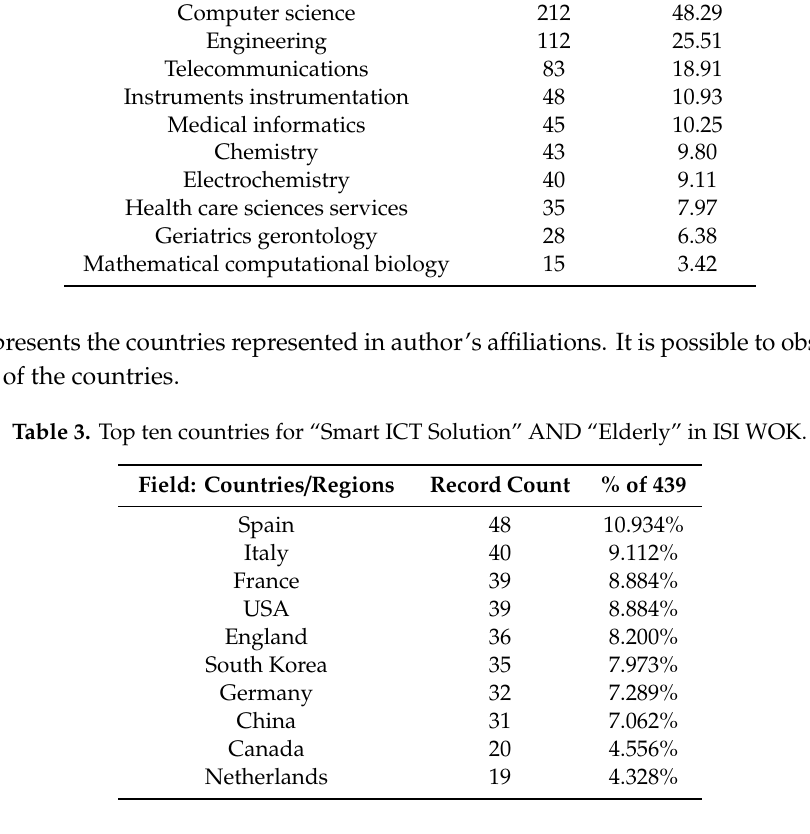
Table 2. Top ten research areas for “Smart ICT Solution” AND “Elderly” in ISI WOK. Field: Research Areas